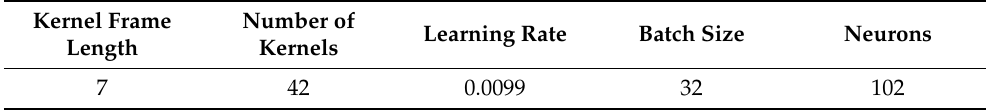
Table 2. The best-fitted seed after the evolution of the CNN architecture with PFA. Kernel